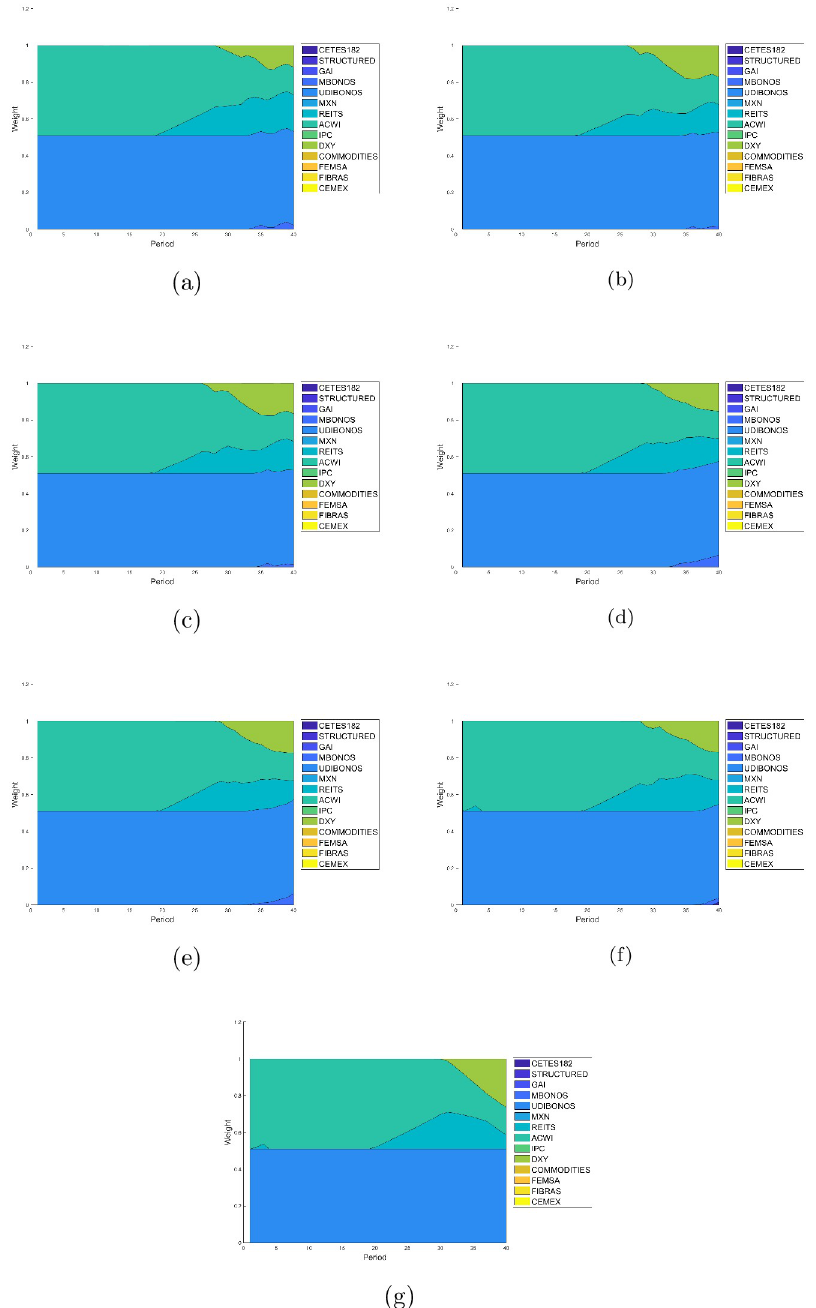
Fig 10. Allocation weights from the solution at the last quartile. (a) Case E1 with E { W ( T )} = 29.2352 and var { W ( T )} = 2.4781. (b) Case E2 with E { W ( T )}= 28.6974 and var { W ( T )} = 2.2212. (c) Case E3 with E { W ( T )}= 28.6974 and var { W ( T )} = 2.4701. (d) Case E4 with E { W ( T )} = 28.2689 and var { W ( T )} = 2.0927. (e) Case E5 with E { W ( T )}= 28.2689 and var { W ( T )} = 2.0181. (f) Case E6 with E { W ( T )} = 29.2605 and var { W ( T )} = 2.3225. (g) Case E7 with E { W ( T )}= 29.2605 and var { W ( T )} = 4.4609.